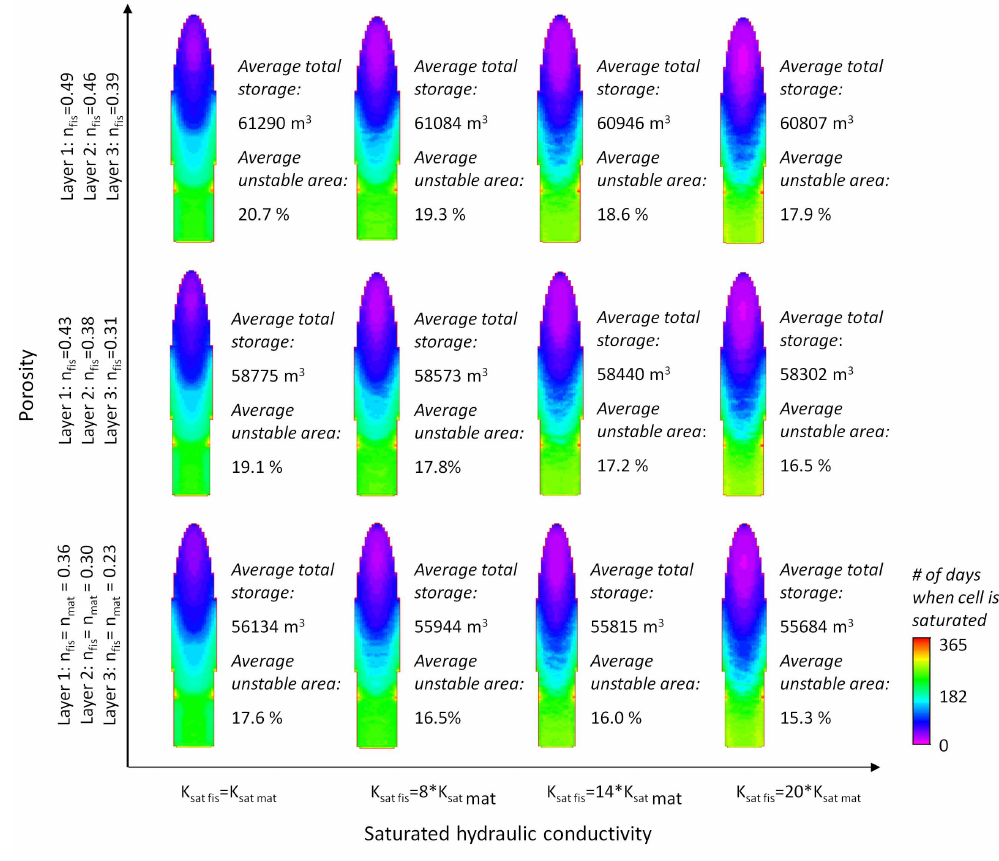
Fig. 10. Sensitivity analysis of the model for changes in the fissure parameterisation. The unstable area is the area of all cells where f s < 1. The plot located in upper right corner is the reference plot – the “dynamic connectivity” scenario. Moving to the left along the x-axis, K sat,fis decreases, while moving down along y-axis, the n fis